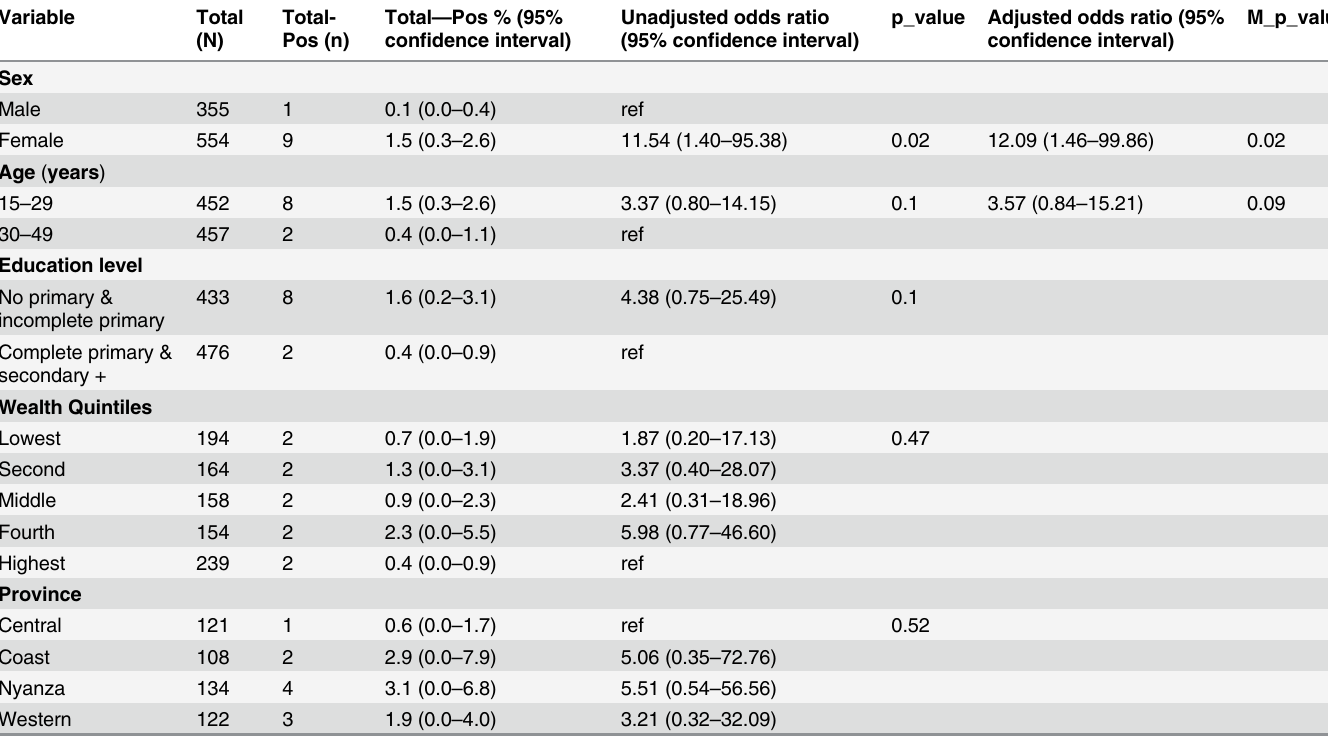
Table 4. Prevalence and factors associated with chikungunya virus among persons aged 15 – 64 years, Kenya,